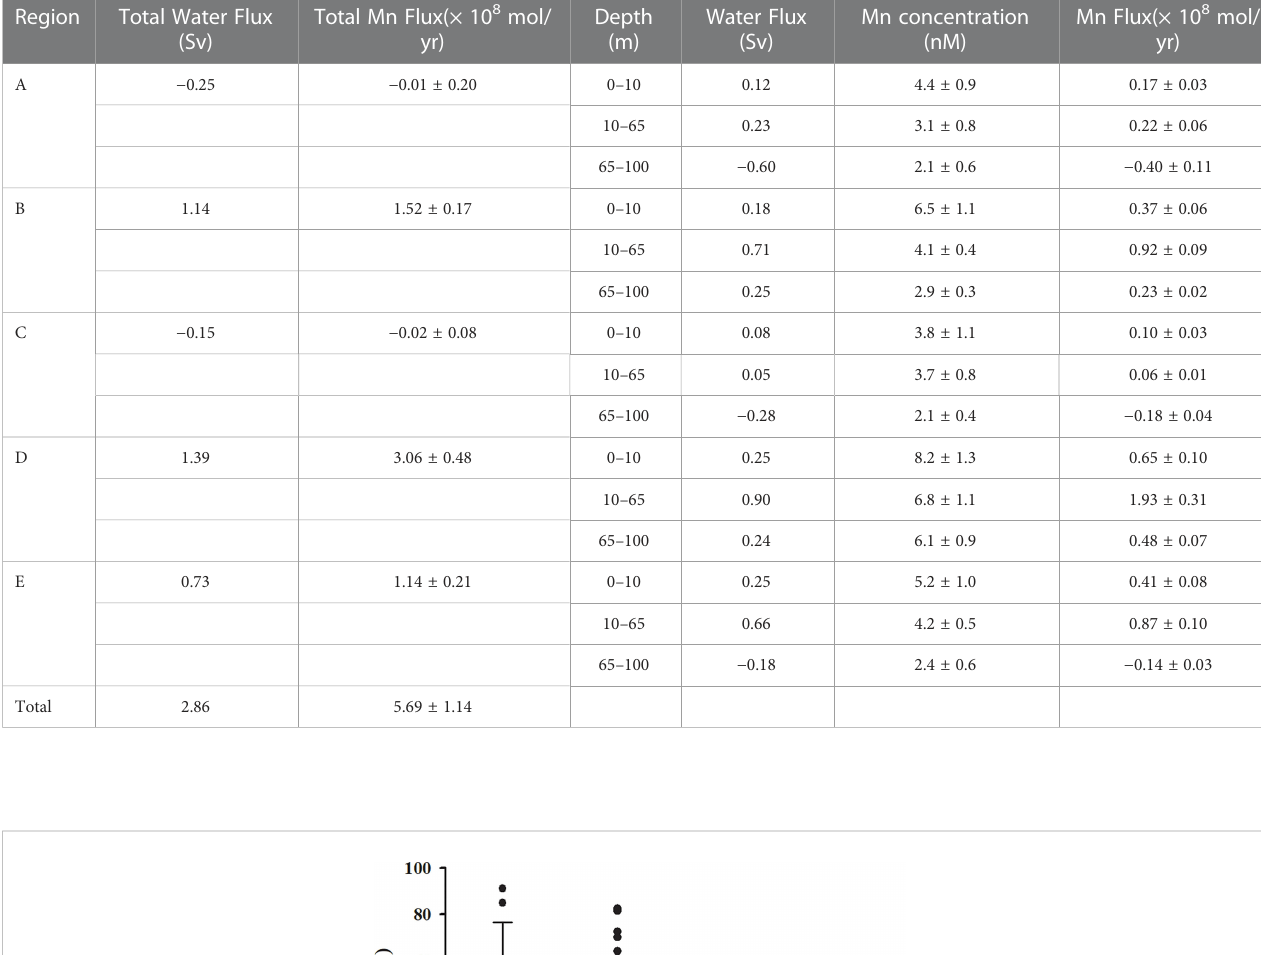
TABLE 2 Fluxes of water and dissolved Mn across the 100 – m isobath in the ECS (+: off – shelf, -: on – shelf). Region